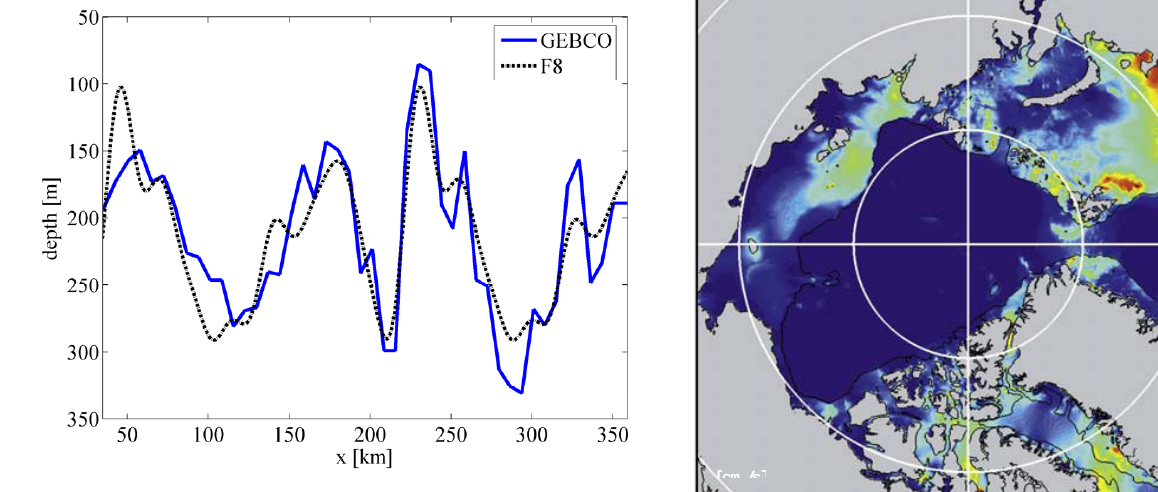
Fig. 2. Bottom relief of the area cross-section shown in Fig. 1 (blue Figure 2. Bottom relief of the area cross-section shown in Fig. 1 (blue line is GEBCO, dotted line is GEBCO, dotted line is the spline). line is the spline).